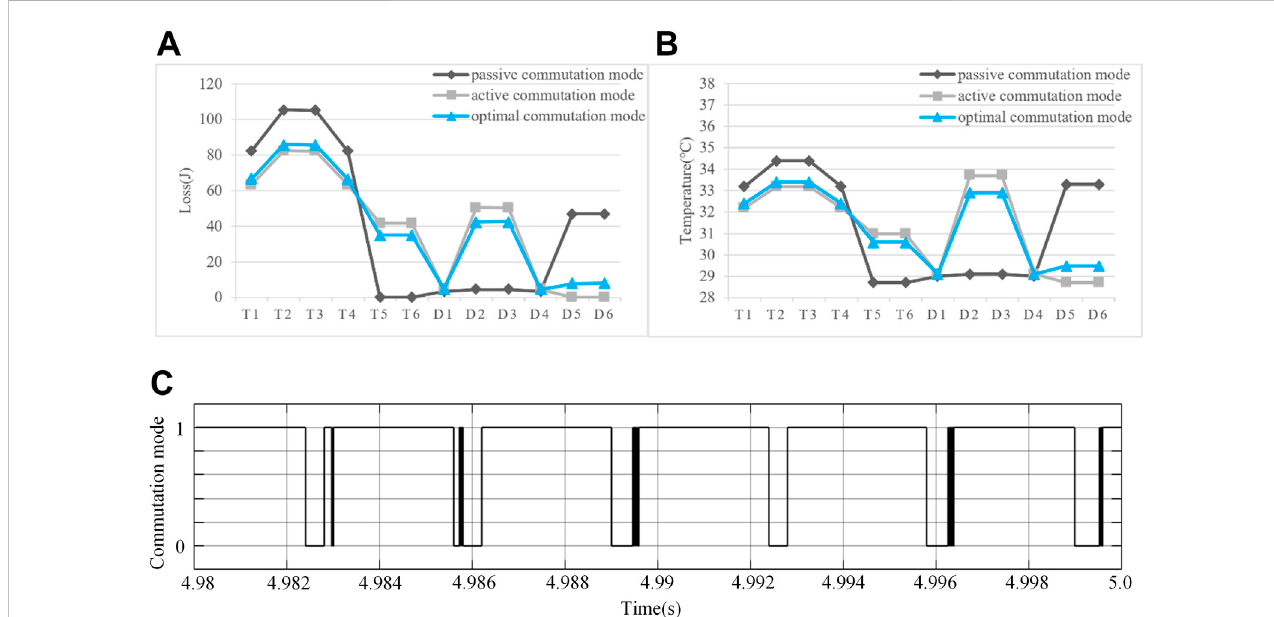
FIGURE 7 Simulation results for constant load (simulated from 0 to 5 s). (A) Cumulative loss distribution. (B) Junction temperature distribution. (C) Selection of optimal commutation mode (0 represents passive commutation mode and 1 represents active commutation mode).